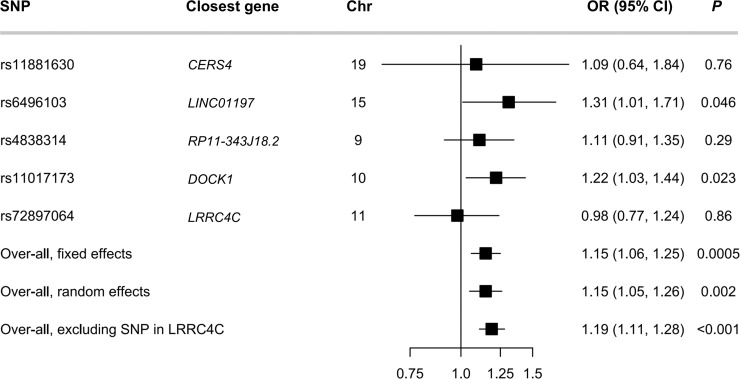
Association between genetically instrumented level of Cer(d18:1/20:1) and type 2 diabetes.Odds ratio (OR) was scaled genetically per 1-SD increase in plasma Cer(d18:1/20:1) level. Estimated effect size was calculated by inverse variance weighting (IVW) analysis using a fixed-effects or random-effects model. P for heterogeneity between estimates from individual SNPs was 0.28 in the analysis including all 5 SNPs and 0.51 in the analysis excluding rs72897064 near LRRC4C. Chr, chromosome; SNP, single nucleotide polymorphism.